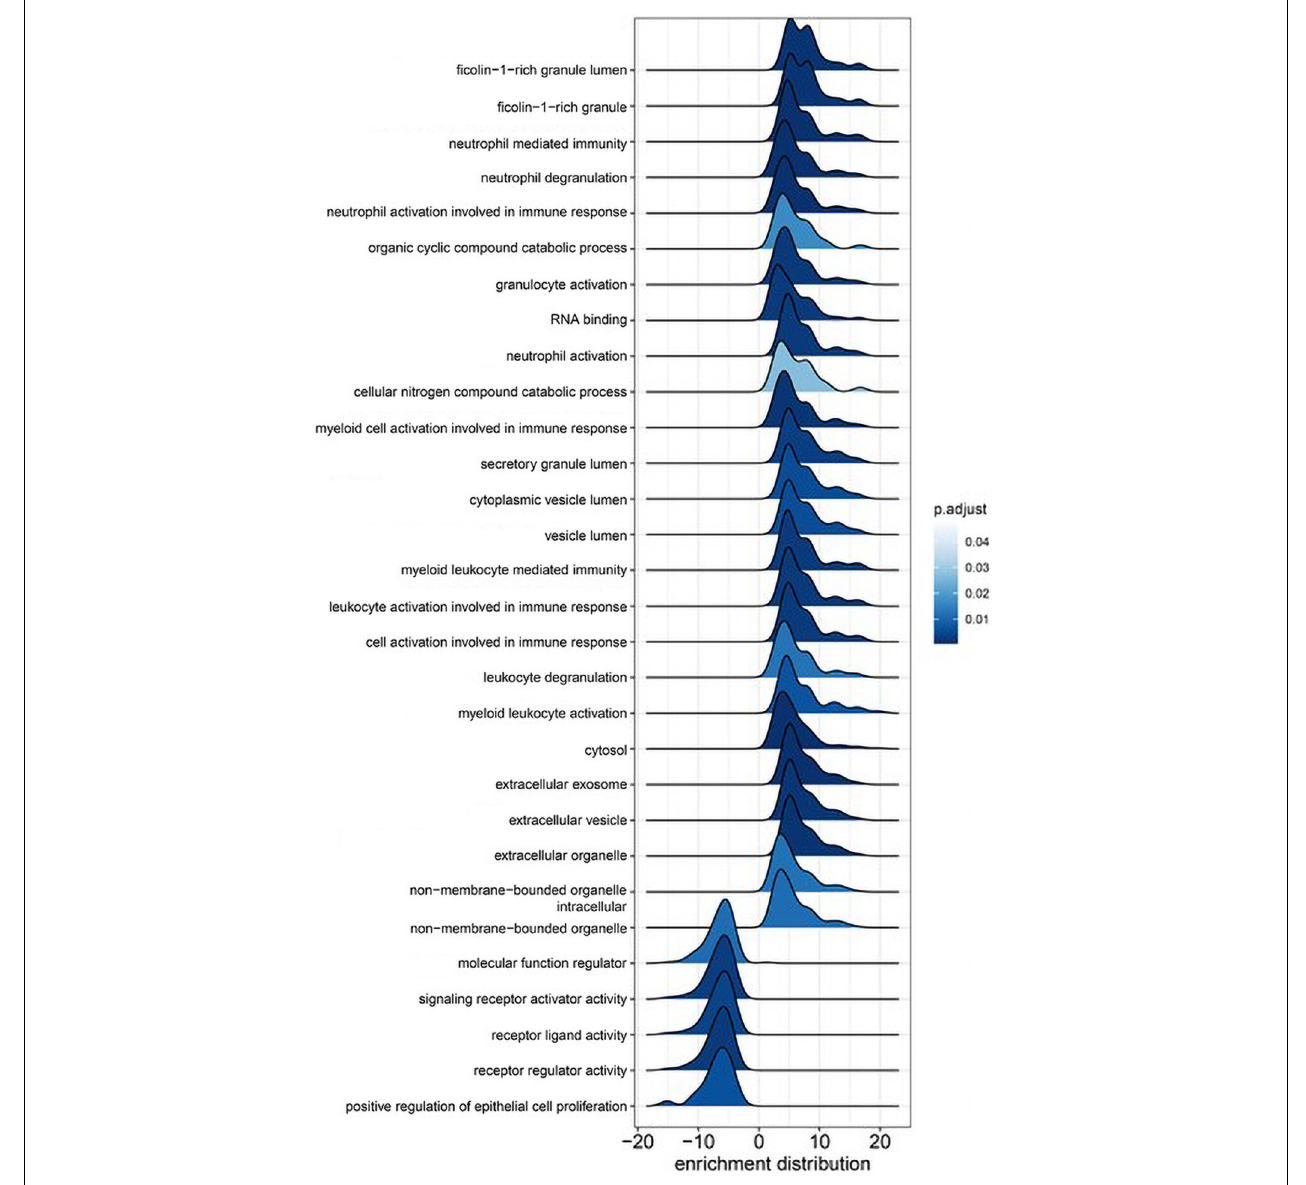
FIGURE 2 | Gene ontology gene set enrichment analysis (GSEA). Immune cell activation and function are highly associated with proteomic changes during cardiac bypass surgery. Ridge plots depict the distribution of core enriched proteins, with positive enrichment scores representing increased expression after